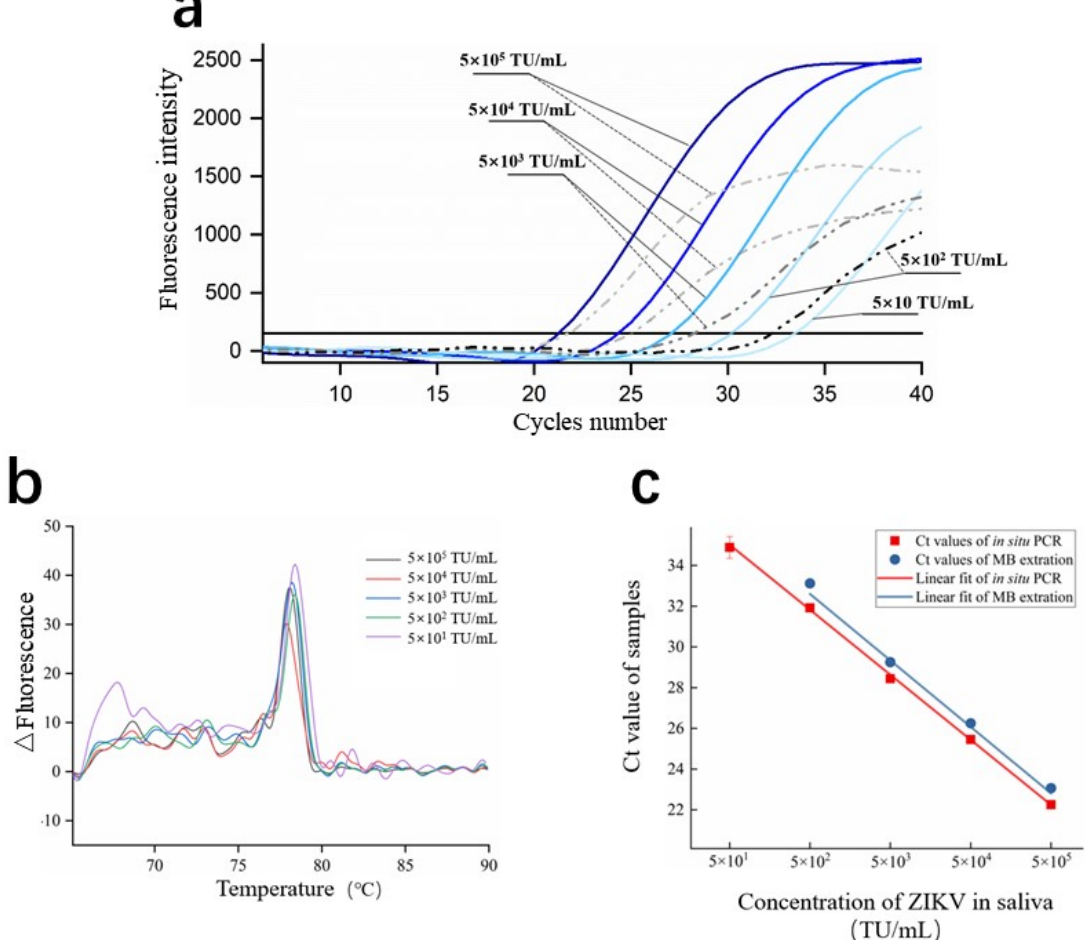
Figure 7. Results of ZIKV RNA sequence amplification in the C 3 -system. ( a ) Amplification curves of ZIKV mixed with saliva on the chip, including method of the capillaries adsorption (solid blue curve) and the kit extraction (dash grey curve). ( b ) Melting curve of sample with a range of concentration. ( c ) Regression curve of concentration of ZIKV samples.